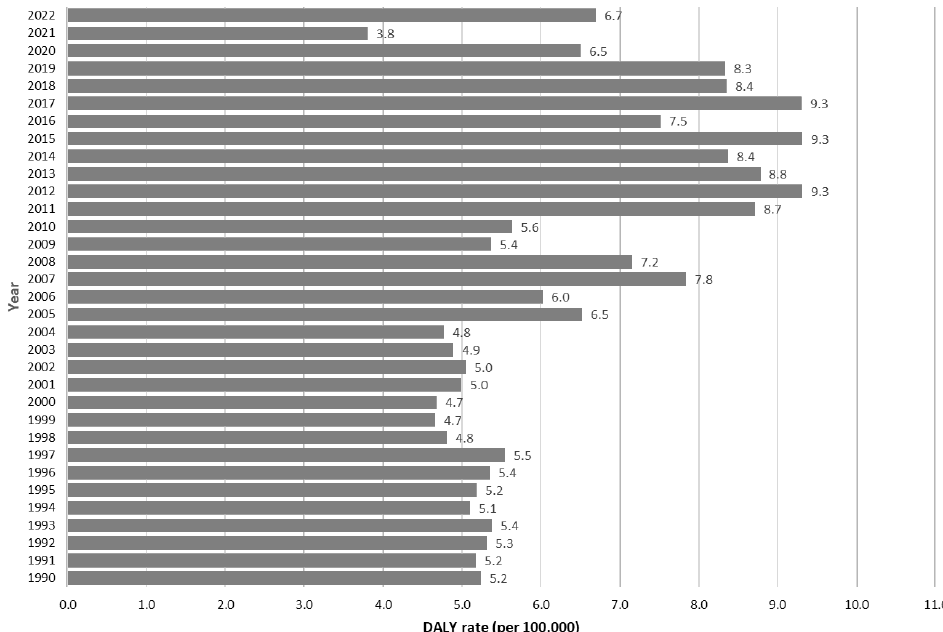
Figure 2. Disability-adjusted life year (DALY) rate of dengue fever, Mexico 1990–2022.